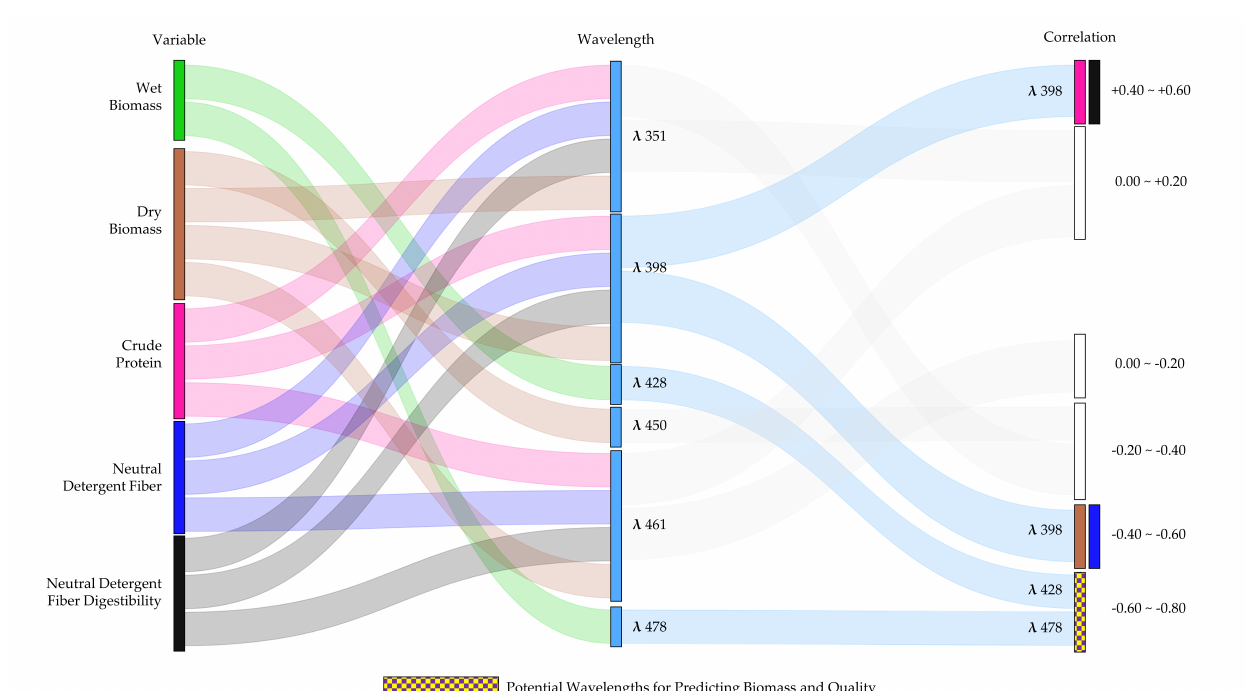
Figure A1. Sankey diagram illustrates the wavelengths in the blue region ( λ 350 − 490) most correlated with alfalfa biomass and quality traits. The flow chart intuitively displays bars and paths drawn in proportion to the amount of information used. The larger the bars, the more times this information has been used. Colored pathways assign the connections between alfalfa biomass and quality traits and its usage in remote sensing data (i.e., wavelengths or vegetation indices) as well as its response to the strength of the correlation. When wavelength or vegetation indices have the potential to be used to establish a relationship with biomass and quality traits, they are marked. The colors of each correlation bar are linked to the biomass and quality traits. When it is white, it is because it has no potential to be used. However, when the bar is colored and checkered, it indicates that although it has not been used to study its relationship with quality, it has the potential to predict it assuming its correlation with